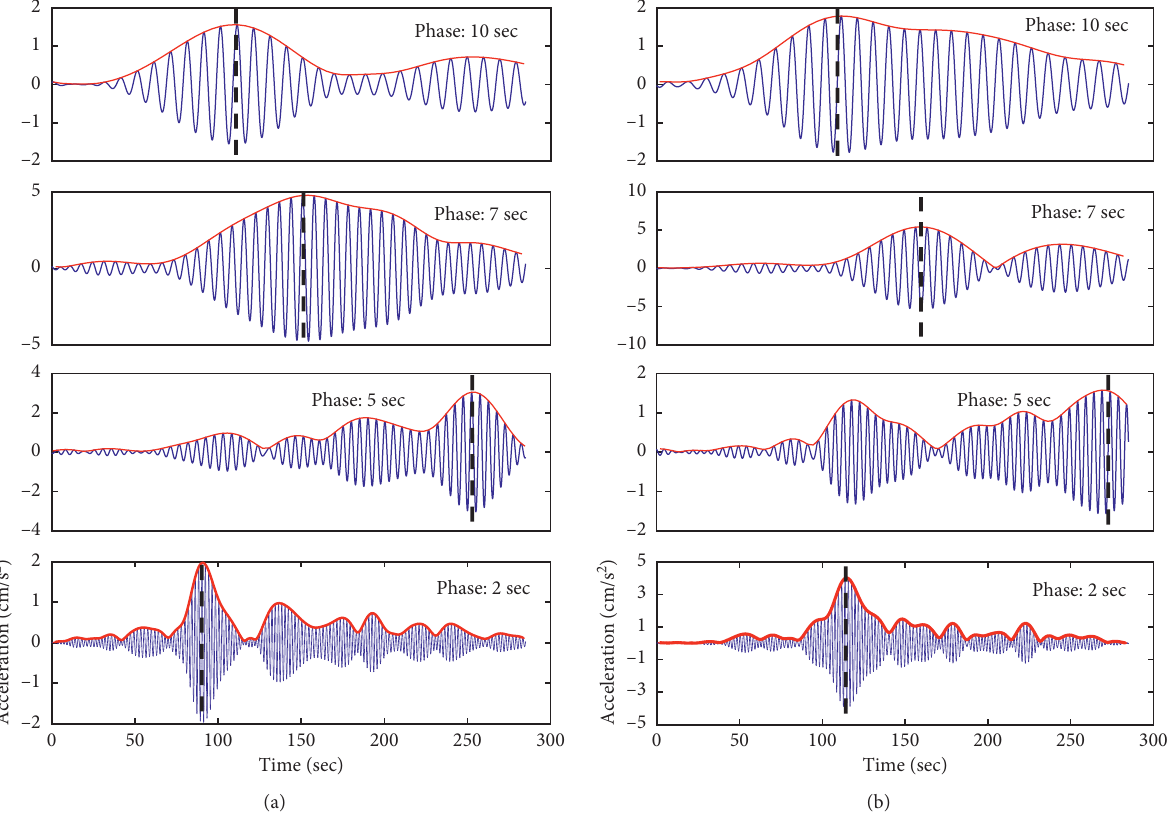
Figure 1: Phases dependent on periods from 2, 5, 7, and 10sec are attained from the acceleration traces of (a) CHB002EW and (b) TKY023EW, by using a set of Gaussian filters.